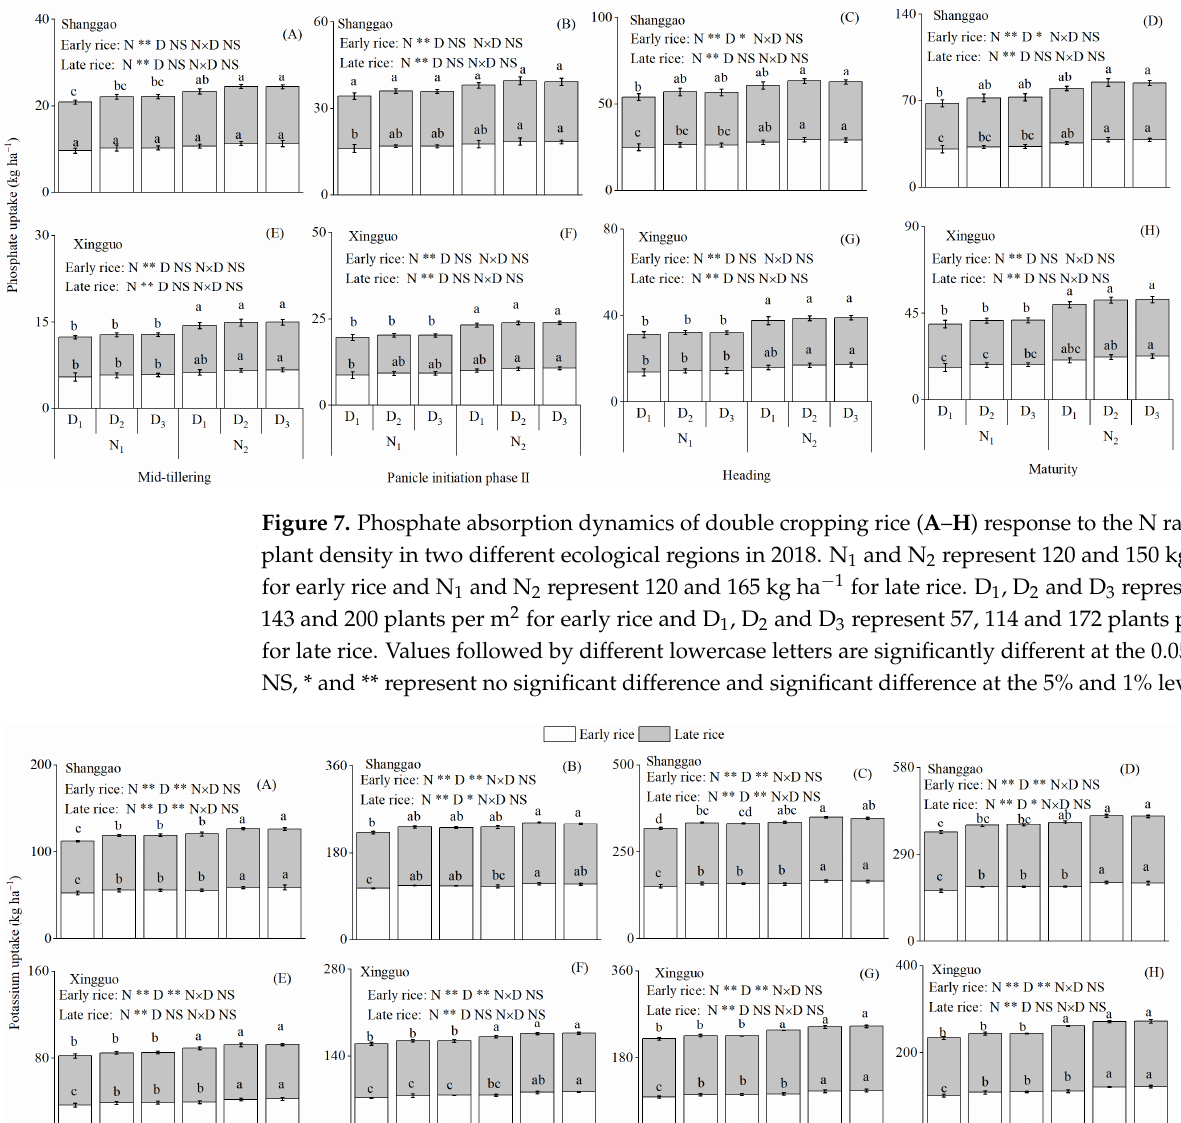
Figure 6. N absorption dynamics of double cropping rice ( A – H ) response to the N rate and plant density in two different ecological regions in 2018. N 1 and N 2 represent 120 and 150 kg ha -1 for early rice and N 1 and N 2 represent 120 and 165 kg ha -1 for late rice. D 1 , D 2 and D 3 represent 86, 143 and 200 plants per m 2 for early rice and D 1 , D 2 and D 3 represent 57, 114 and 172 plants per m 2 for late rice. Values followed by different lowercase letters are significantly different at the 0.05 level. NS, * and ** represent no significant difference and significant difference at the 5% and 1% levels.